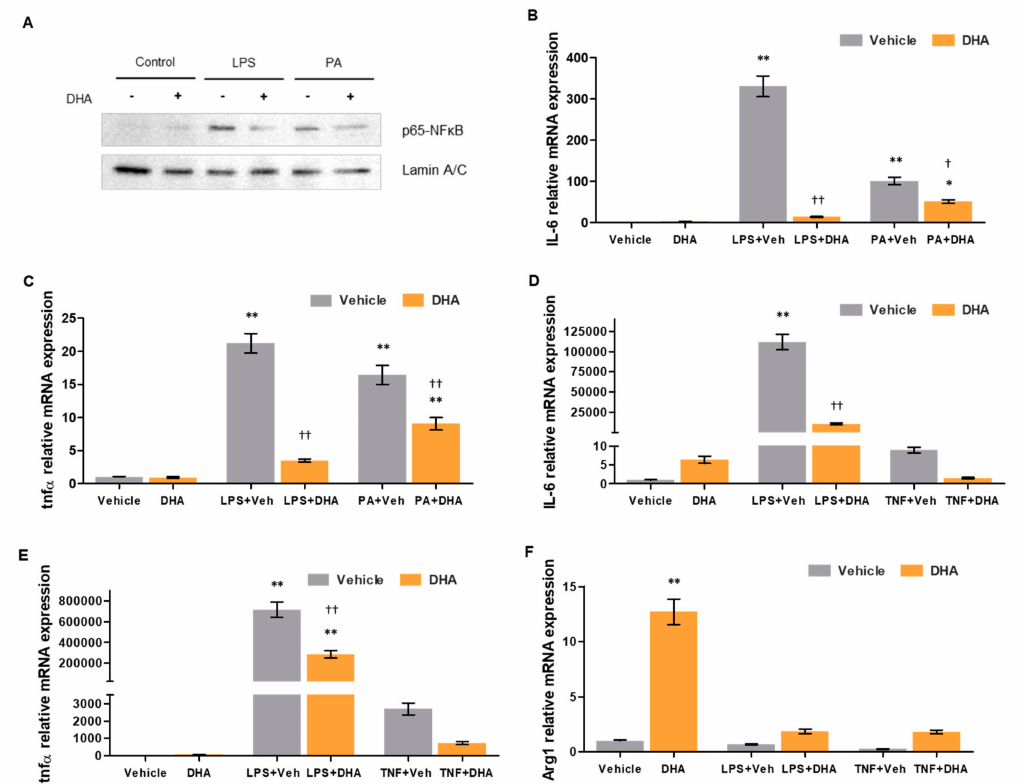
Figure 2. E ff ects of DHA on macrophage activity. ( A ) p65-NF κ B (nuclear factor kappa B) nuclear protein expression in murine macrophages from the RAW264.7 cell line treated with DHA (10 µ